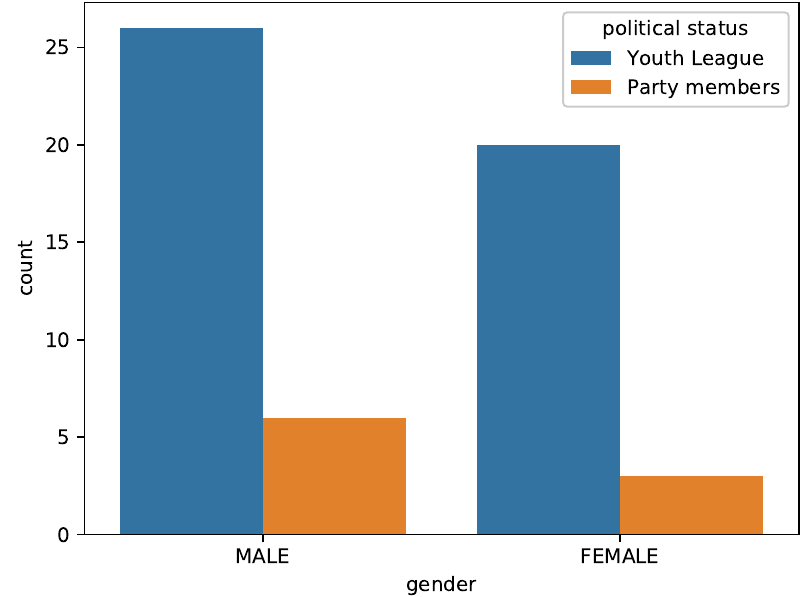
Figure 8. The relationship between gender and the proportion of party